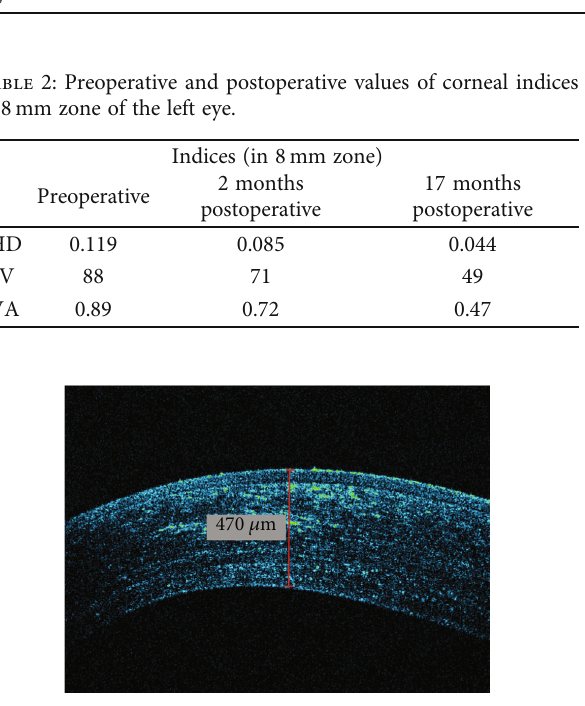
Figure 3: AS-OCT of keratoconus eye 17 months after DISC ablation and corneal crosslinking radiating with UV-A at 3mW/cm 2